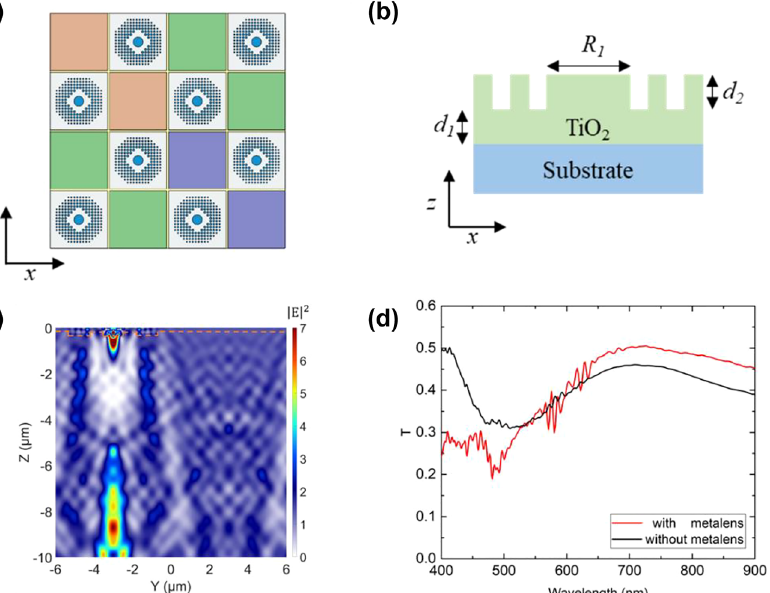
Figure 2: Schematic diagrams and simulation results of the axicon metalens. (a) Schematic of the Bayer RGBW CFA 2.0 layout with the inserted axicon metalens for W pixels. The pixel size of each mosaic is 6 × 6 μ m. (b) Schematic of the proposed axicon metalens for broadband light-harvesting; d represent the height of the TiO nanopost and the thickness of the bottom TiO layer, respectively. (c) Electric field distribution at the yz plane for d 2 2 2 𝜆 = 700 nm. (d) Simulated transmission spectrum of the Bayer RGBW CFA 2.0 layout with the axicon metalens inserted at W pixels. The black and red solid lines indicate the transmission at the RGB pixel (without the metalens) and at the W pixel (with the metalens),